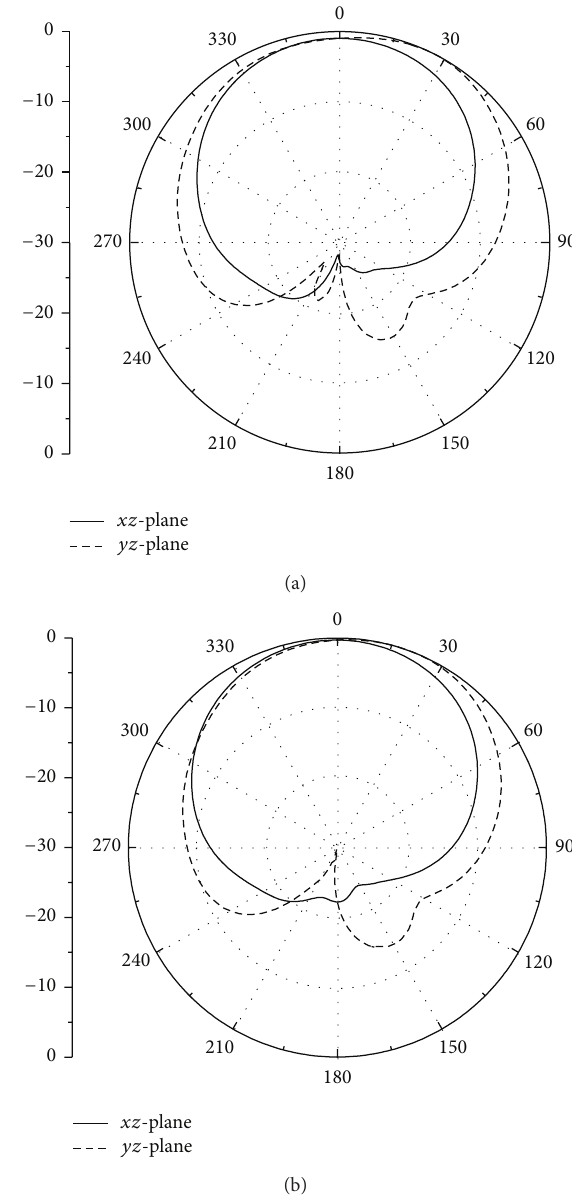
Figure 10: The simulated radiation pattern of the patch array at 3.35 GHz. (a) Without DGS; (b) with